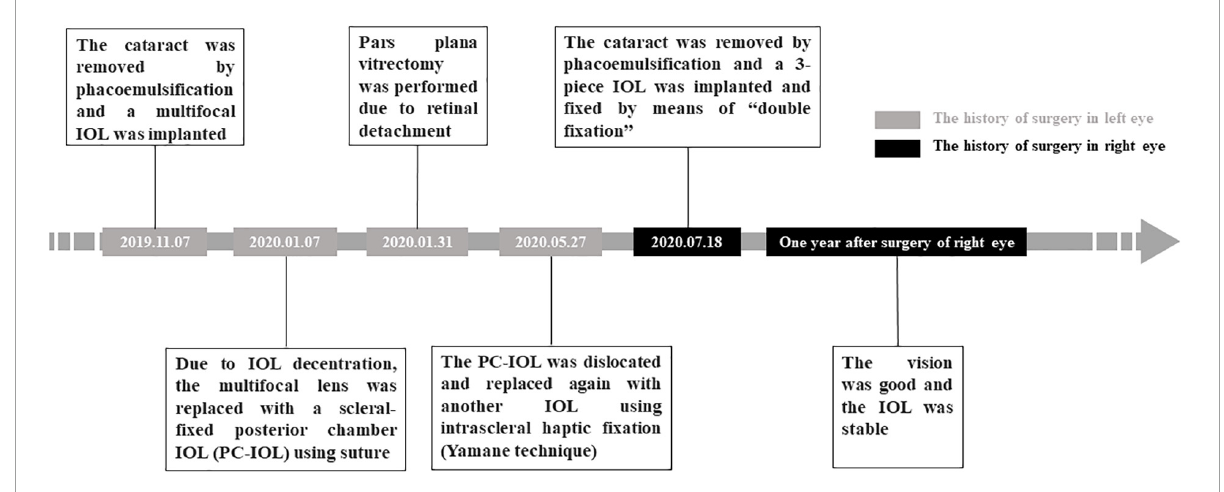
FIGURE1 Timeline of the major surgical interventions in the patient’s both eyes.